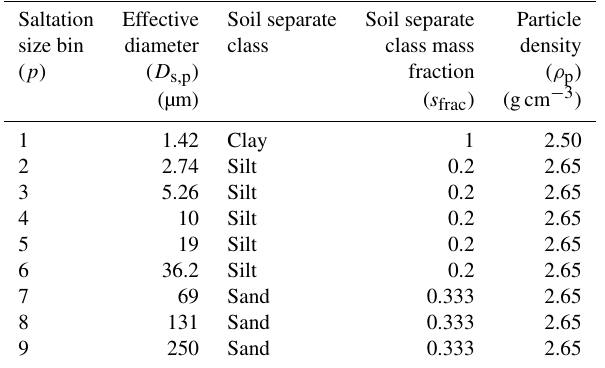
Table 1. Saltation particle size bins and their associated attributes. Particle sizes are presented here in µm but handled in units of cen- timeters within the model.